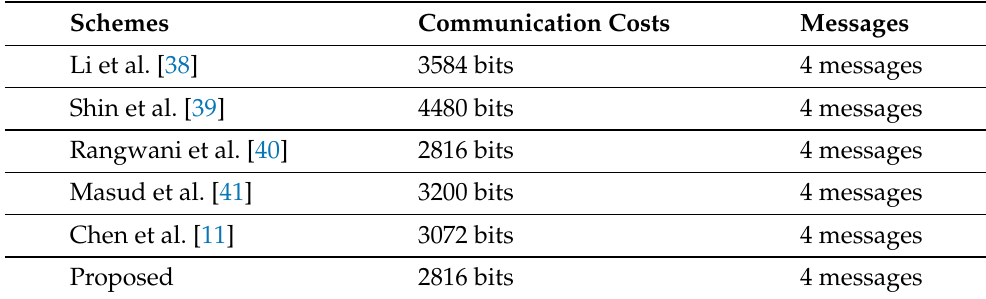
Table 5. Comparison of communication costs required for